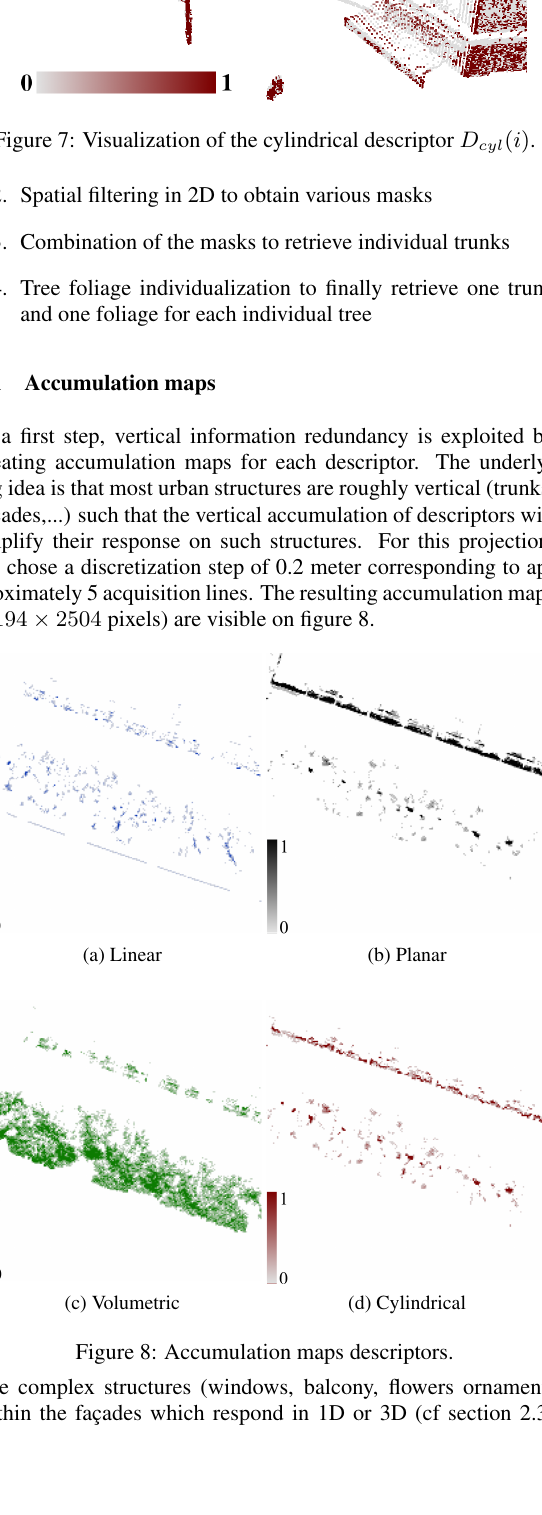
Figure 6: Descriptor confusions: linear and planar descriptors have the same response over posts and trunks.